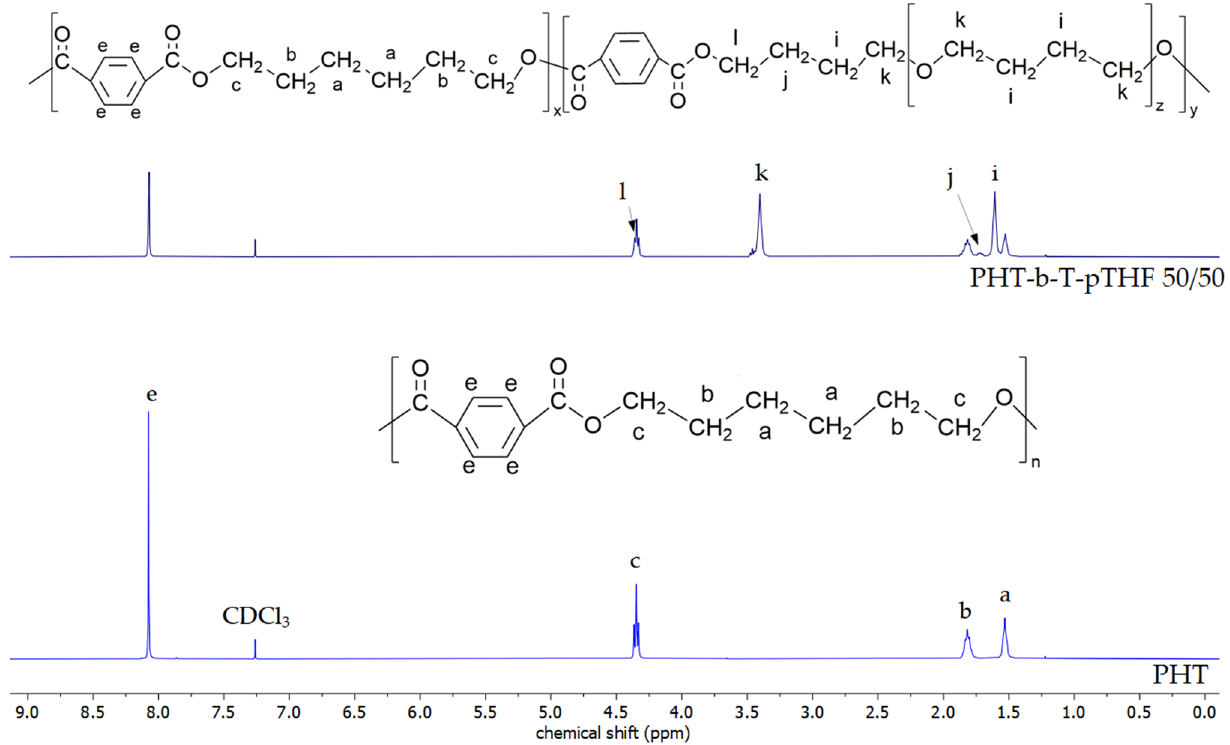
Figure 4. Structure and NMR spectra of PHT and PHT-b-T-pTHF 50/50.